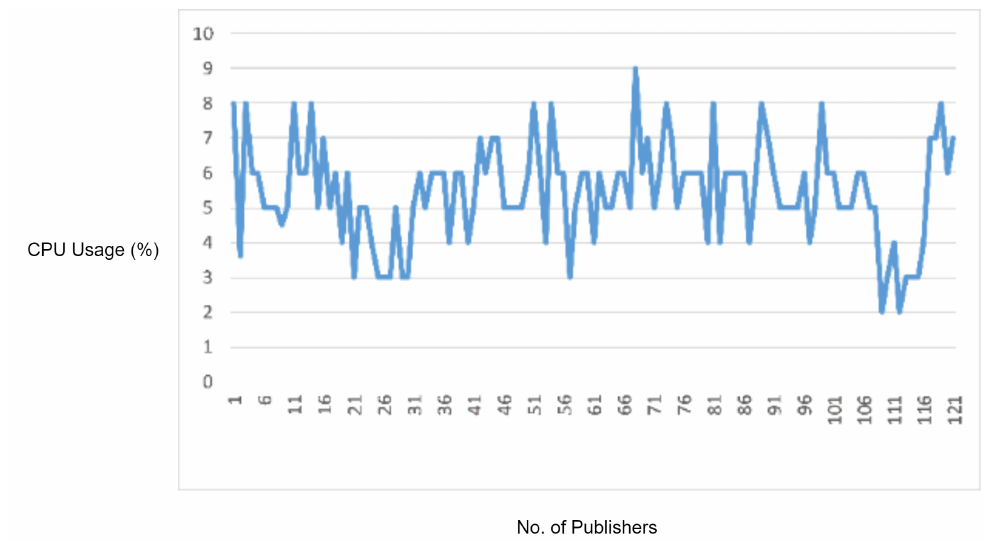
Figure 14. CPU usage captured while performing MQTT DoS attacks when IDS rules are